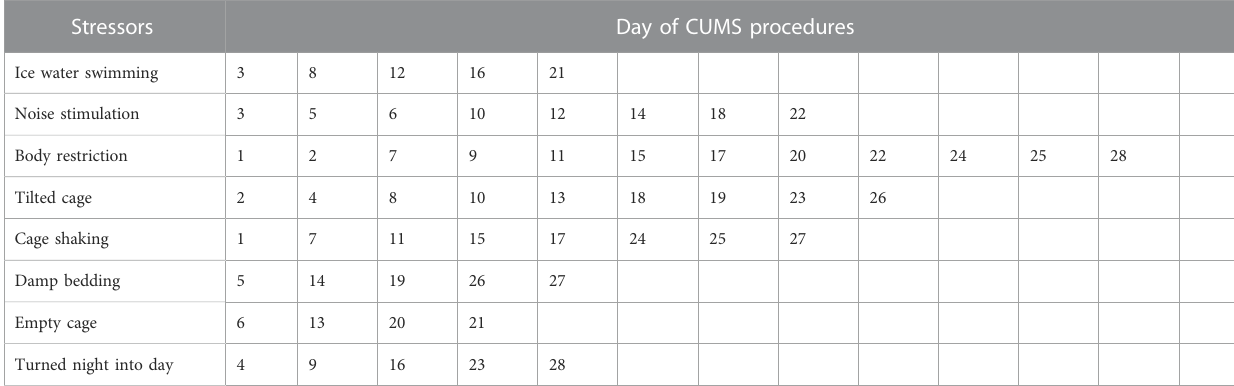
TABLE 1 Chronic unpredictable mild stress (CUMS)